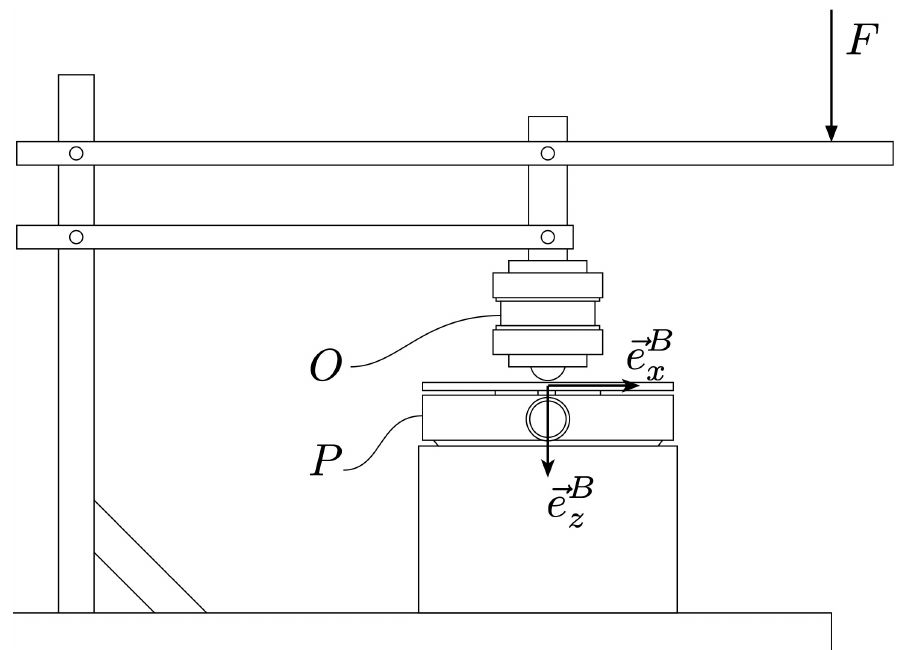
Figure 6. Schematic representation of the force-calibration setup. Depending on the mounting mode of the pedal P , the operator can apply forces F to P and collect, simultaneously, data coming from P and the reference sensor O . Three mounting modes are possible, enabling loading in F x , F z , and M x